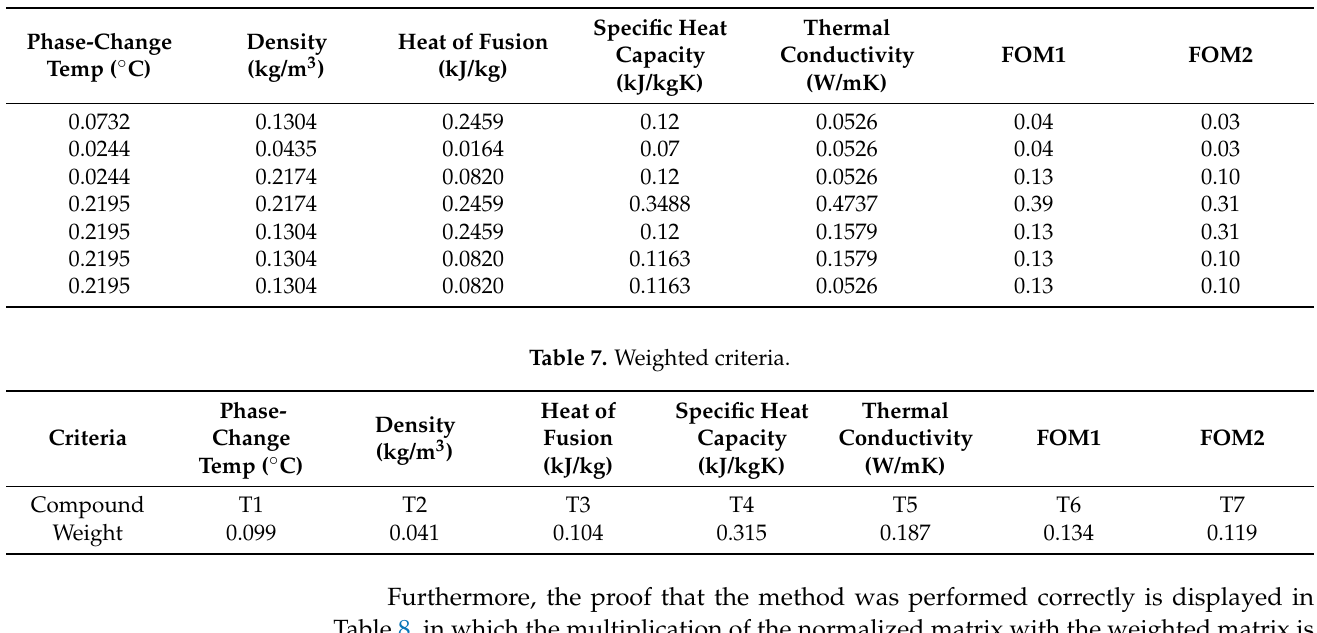
Table 6. Normalized matrix of the criteria.